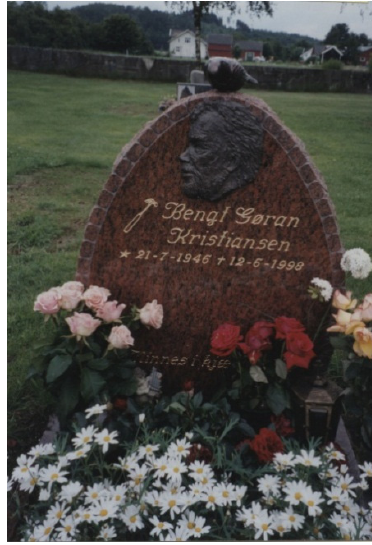
Figure 1. A bronze portrait fastened to the front of a gravestone erected in memory of